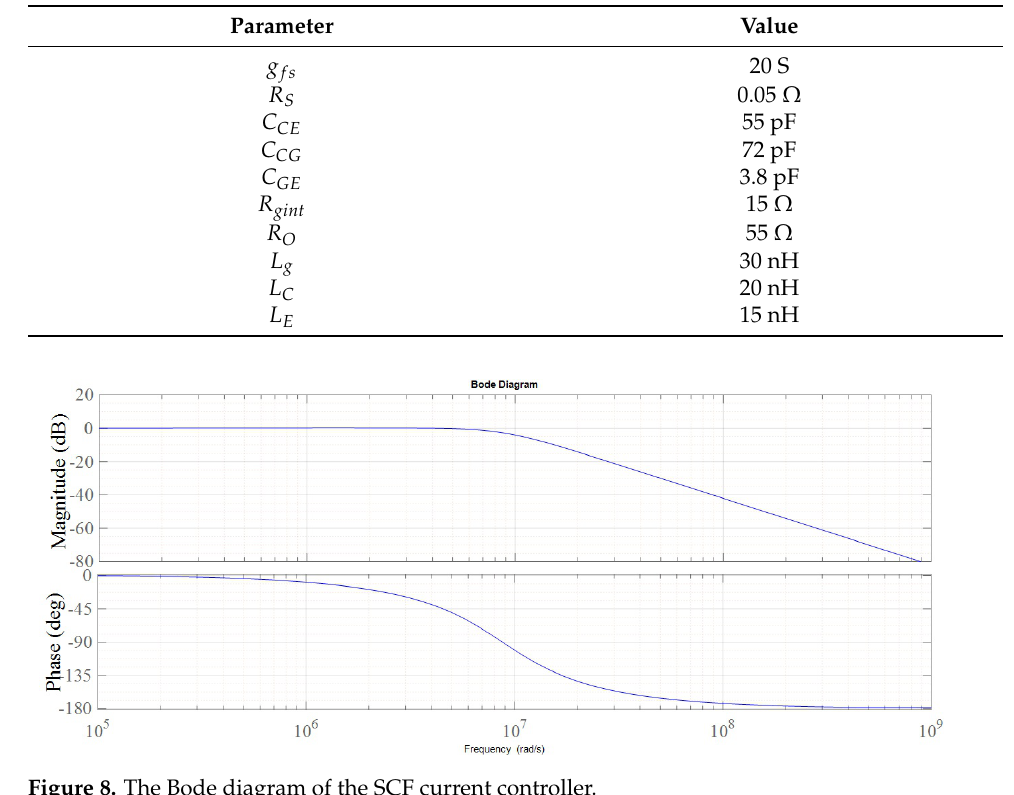
Figure 8. The Bode diagram of the SCF current